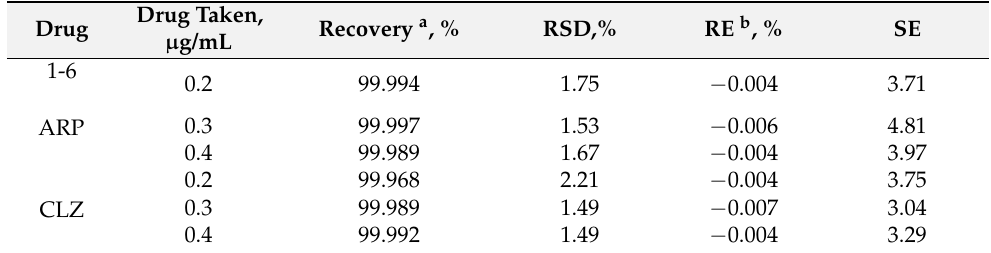
Table 2. Evaluation of intra-day accuracy and precision of the proposed spectrofluorimetric method.